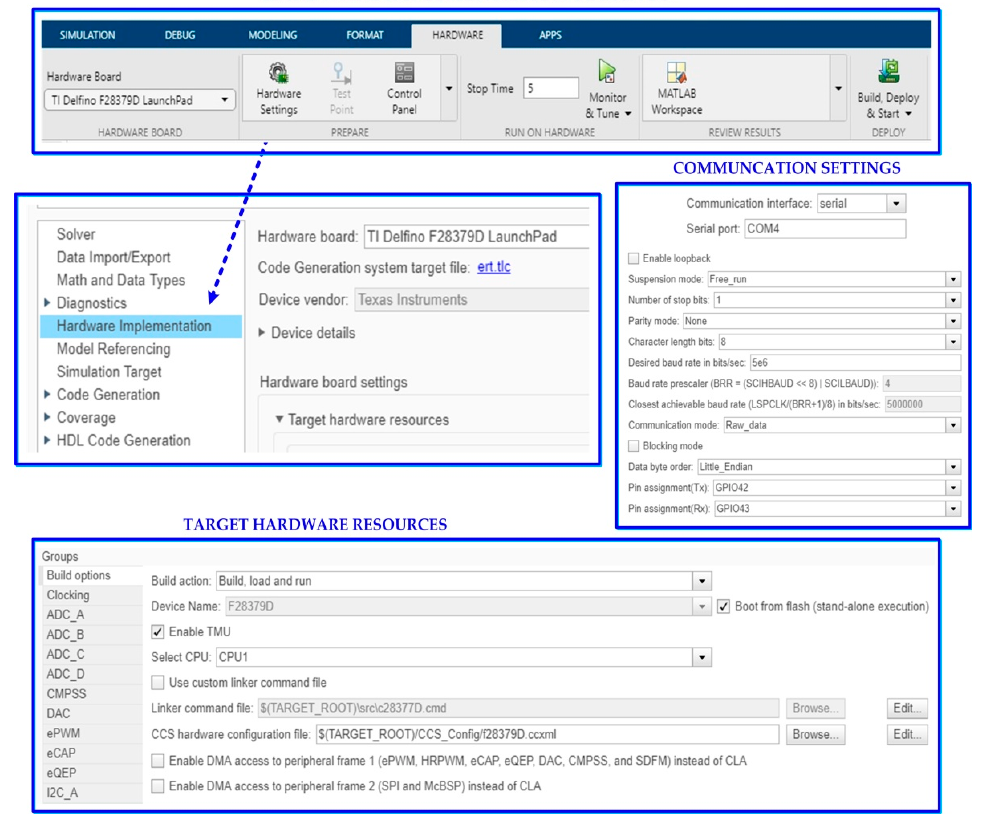
Figure 25. Hardware implementation settings for the PIL stage of the PMSM control system.